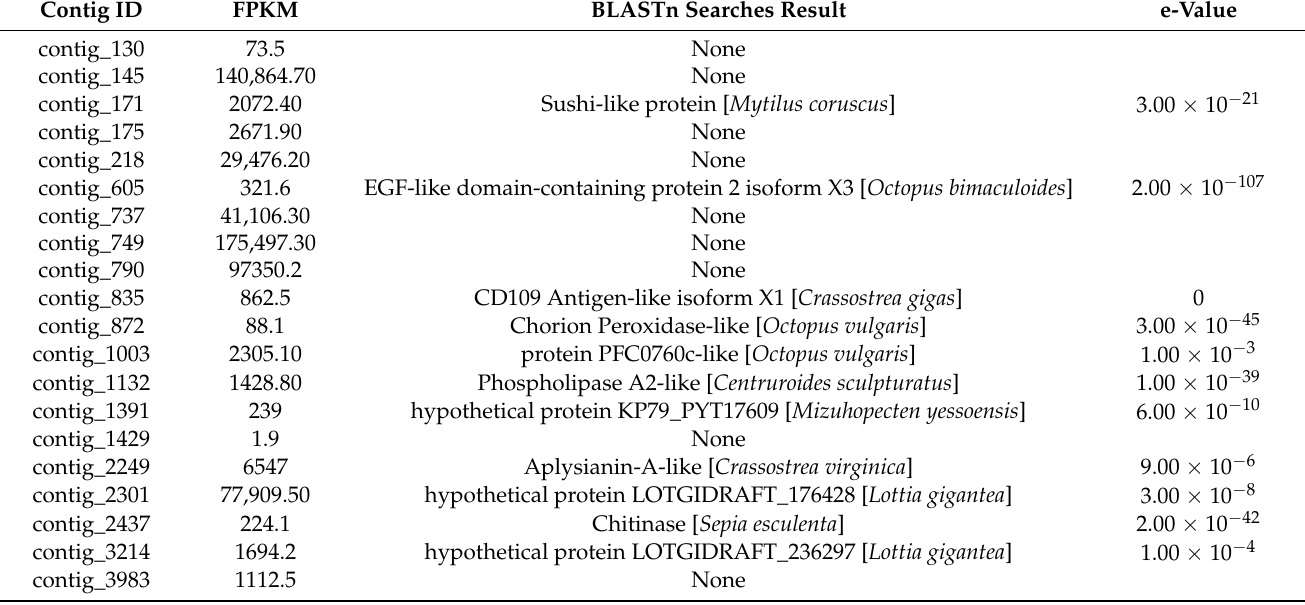
Table 1. Annotation results of the 47 transcriptome contigs, which were identified as Shell Matrix Protein-coding genes by proteome analysis in Nautilus pompilius